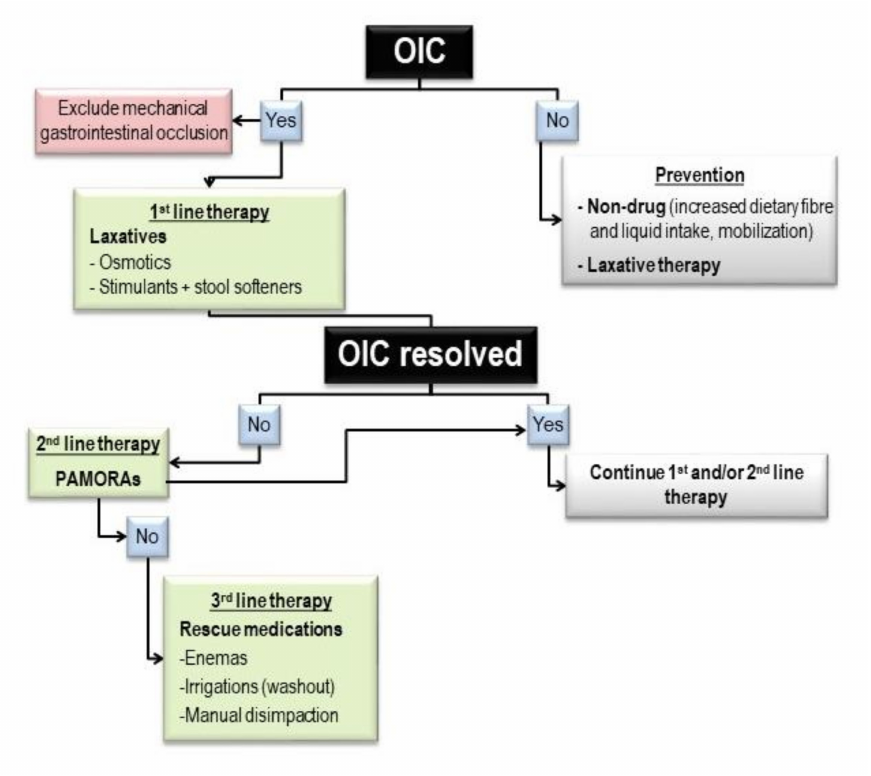
Figure 1. Treatment of constipation in cancer patient on opioid